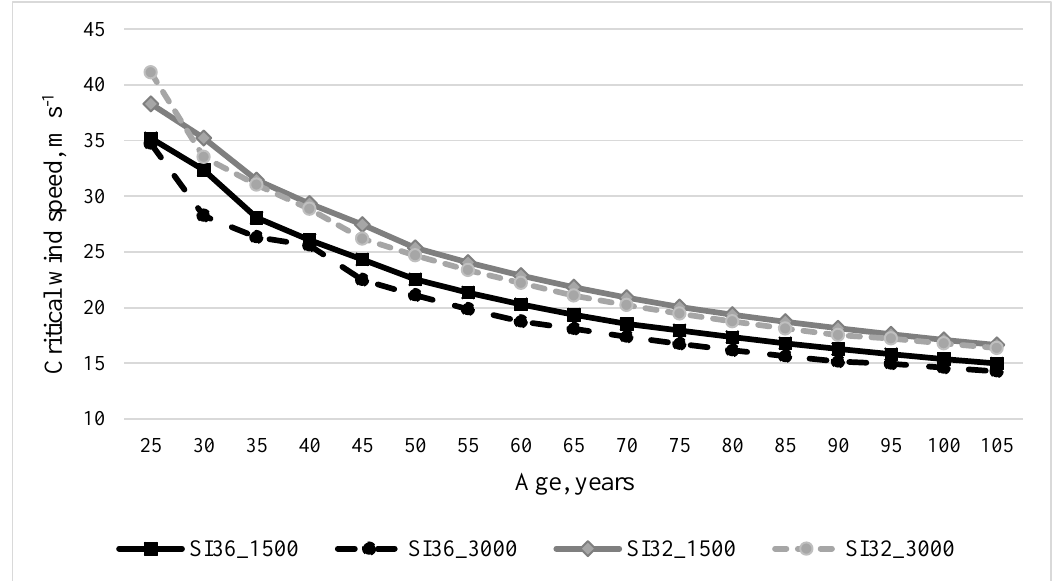
Figure 2. Changes in critical wind speed depending on the site index (SI) 36 and 32, as well as on initial stand density (numbers 1500 and 3000—initial planting density, trees ha −1 ).